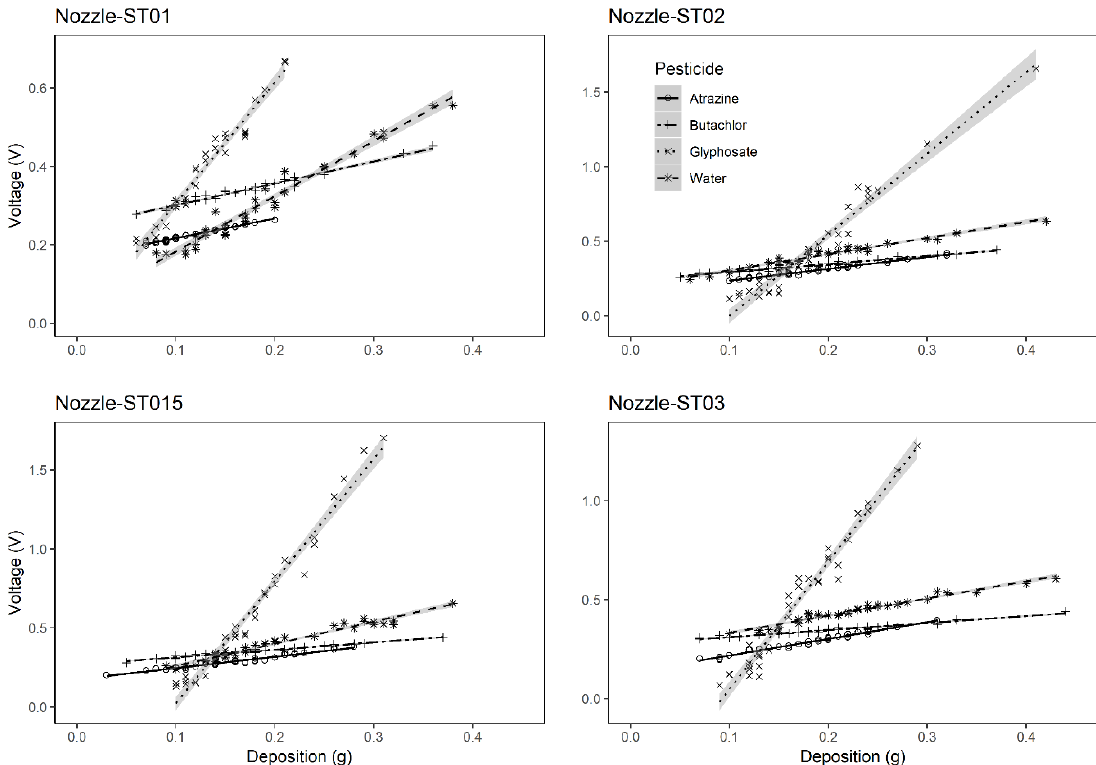
Figure 4. Linear regression models of the deposit data of sprays with droplet size spectrum generated from different nozzles. The shadow area represents the standard error of the regressed linear models.